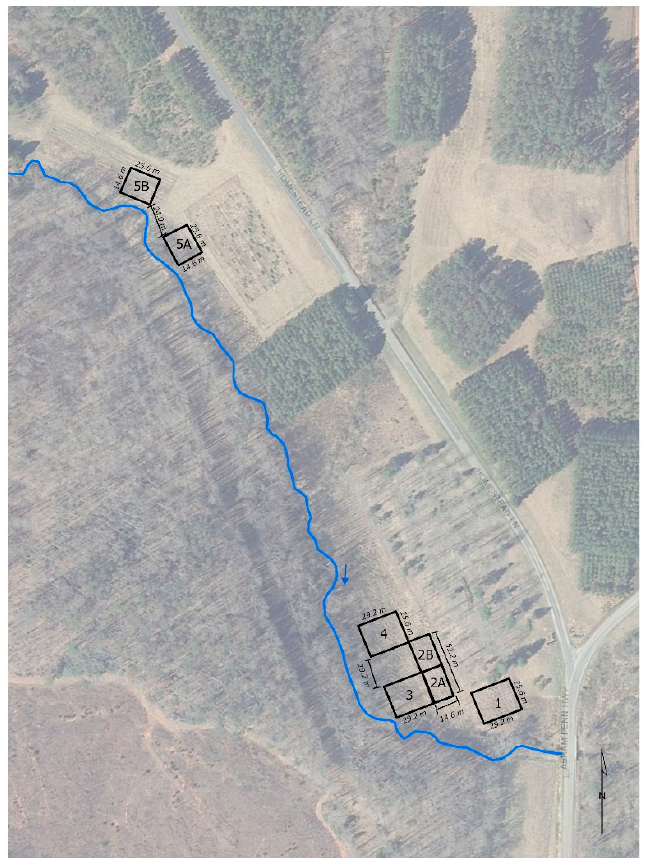
Figure 2. Experimental block layout, with each block encompassing 747.5 m 2 . Blocks were spaced according to presence of hydric soils within the riparian area.